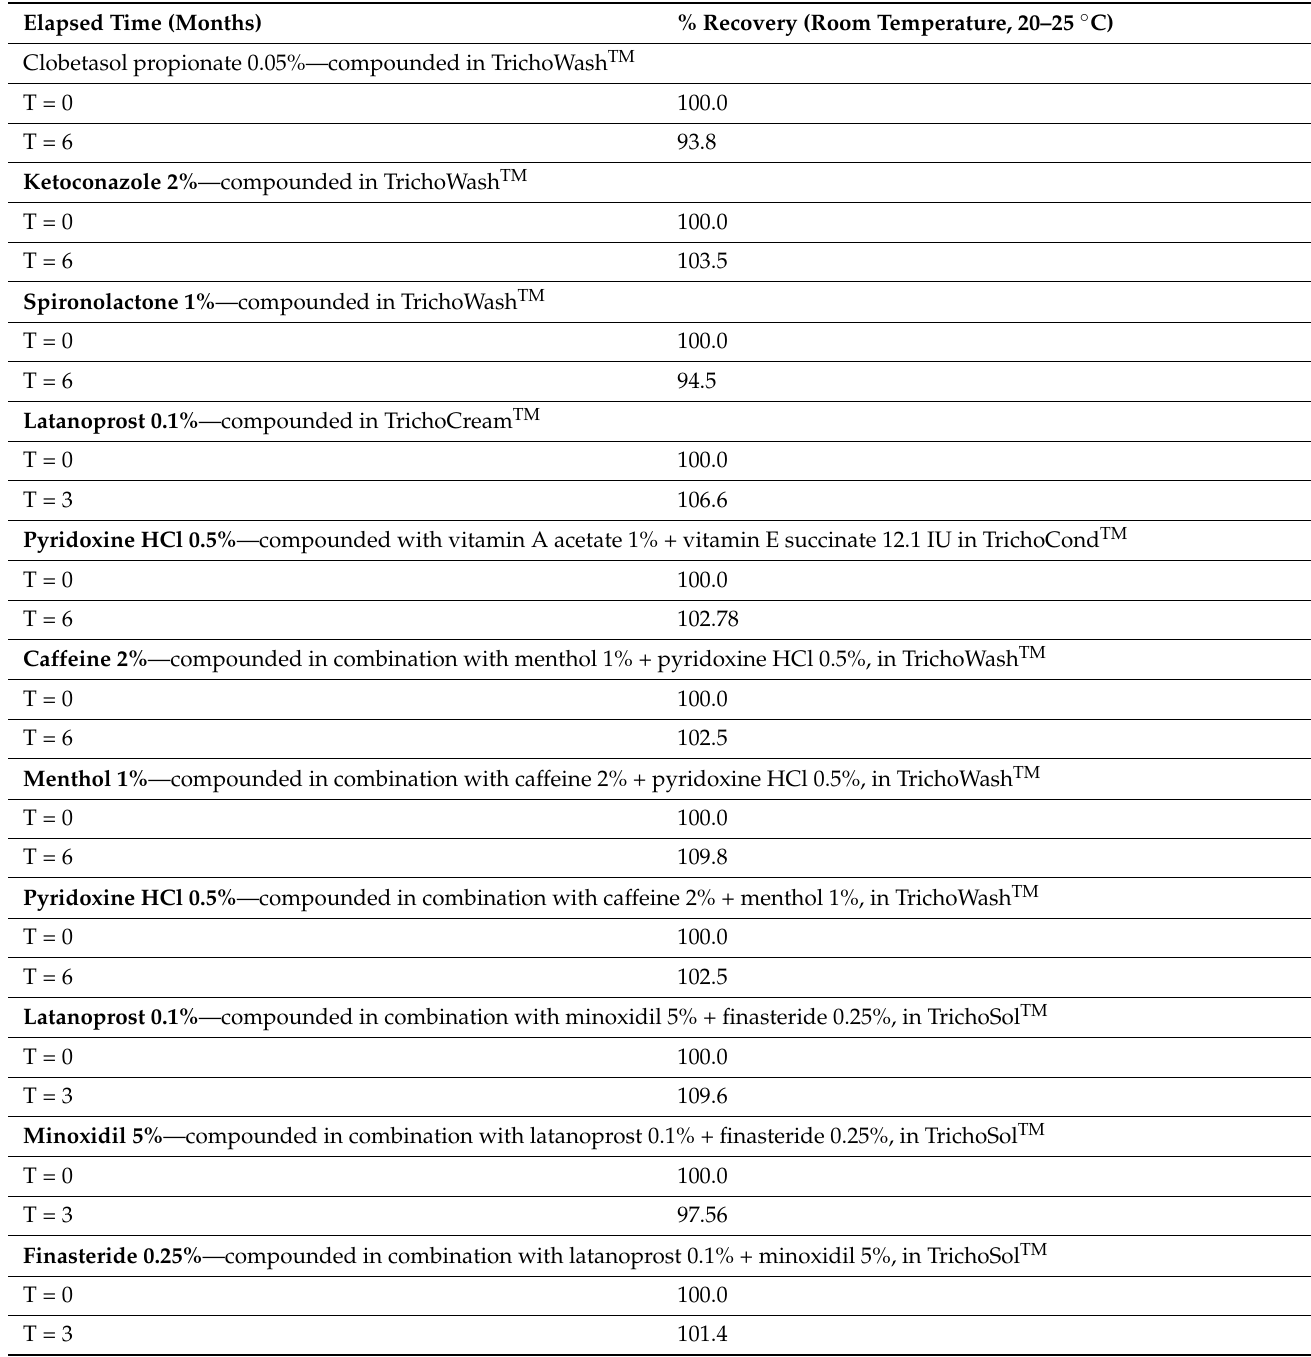
Table 3. Compatibility of the Active Pharmaceutical Ingredients in the Hair